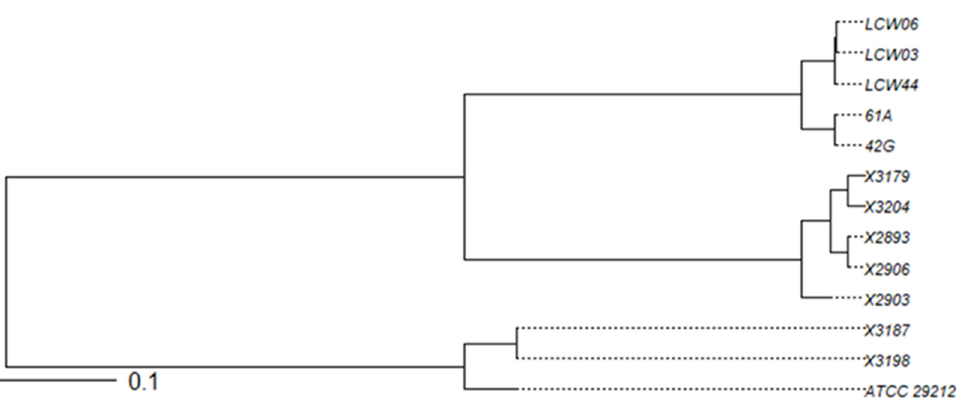
Figure 3. Phylogenetic tree based on the average nucleotide identity (ANI) of the 12 BP+ enterococci. The reference strain, ATCC 29212, was also included.